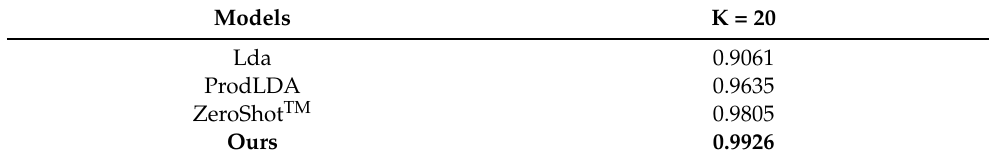
Table 3. Comparison of topic diversity (RBO cepstral) scores of different models.